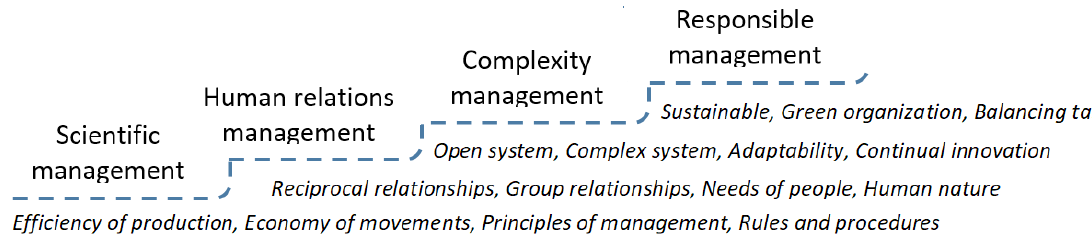
Figure 2. Continuation of management